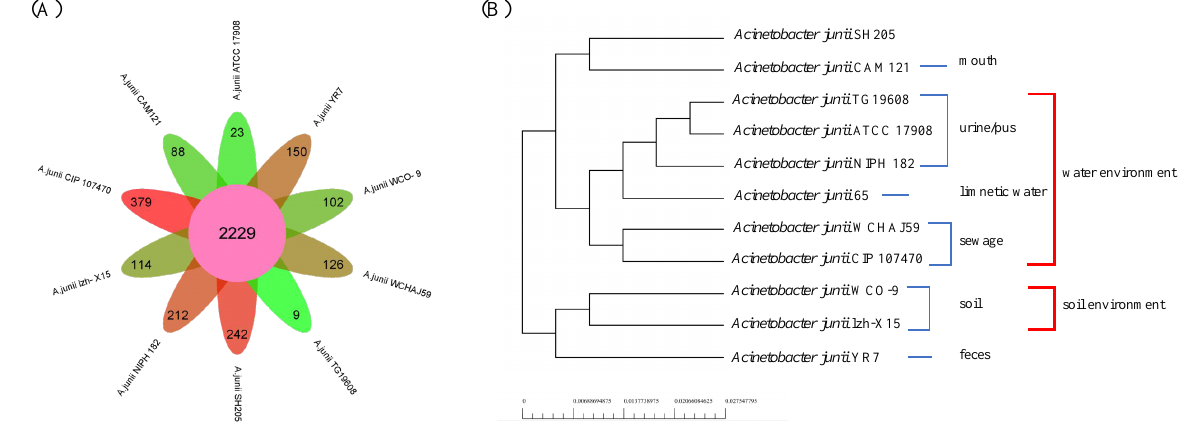
Microorganisms 2023 , 11 , x FOR PEER REVIEW 10 of 16